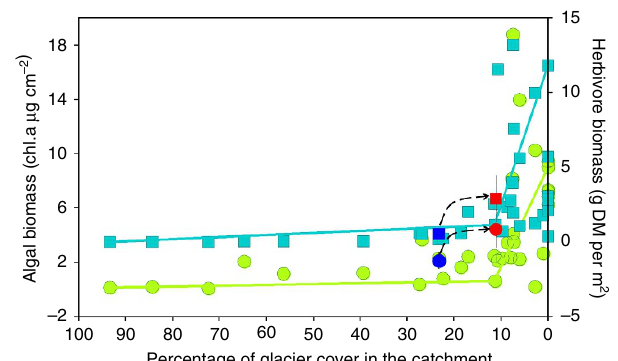
Figure 4 | Spatial variability in algae and herbivores along a glacier influence gradient. Relationship between algal (chl.a, chlorophyll a; green dots) and herbivore biomass (blue squares) as a function of the percentage of glacier cover in the catchment for 33 streams in the Antisana reserve (Ecuador). Douglas–Peucker (DP) models are fitted to algal and herbivore biomass. Data (mean 95% confidence interval) of algal (dots) and herbivore (squares) biomass obtained in our flow-reduction experiment are shown in blue (base flow) and red (low flow). The dashed line represents the shift from low to high level of algal and herbivore biomass between base flow and flow alteration